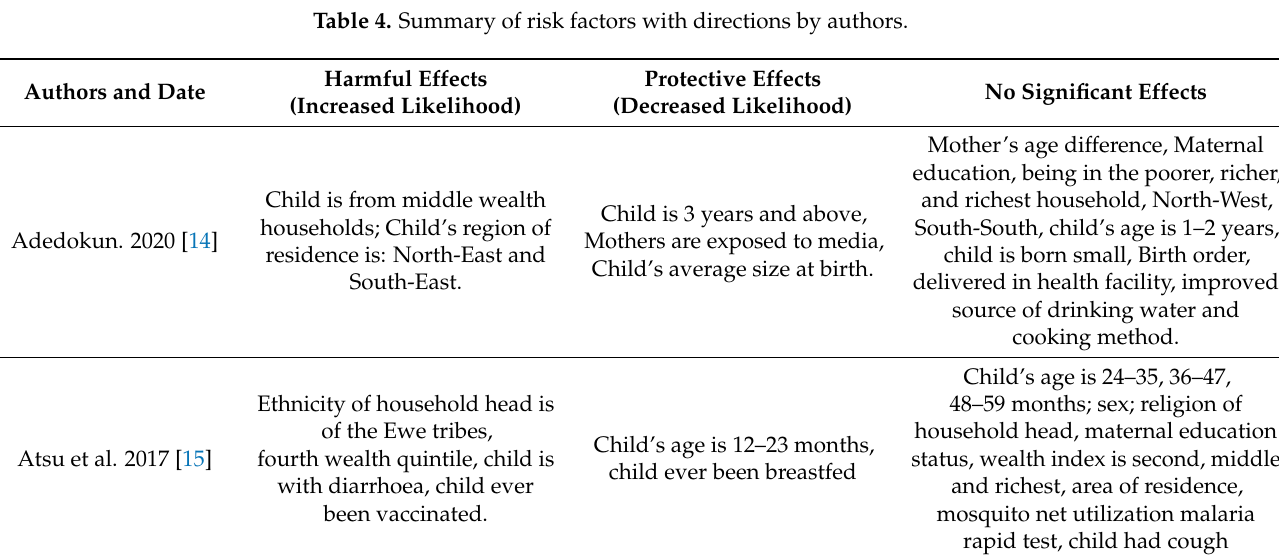
Table 4. Summary of risk factors with directions by